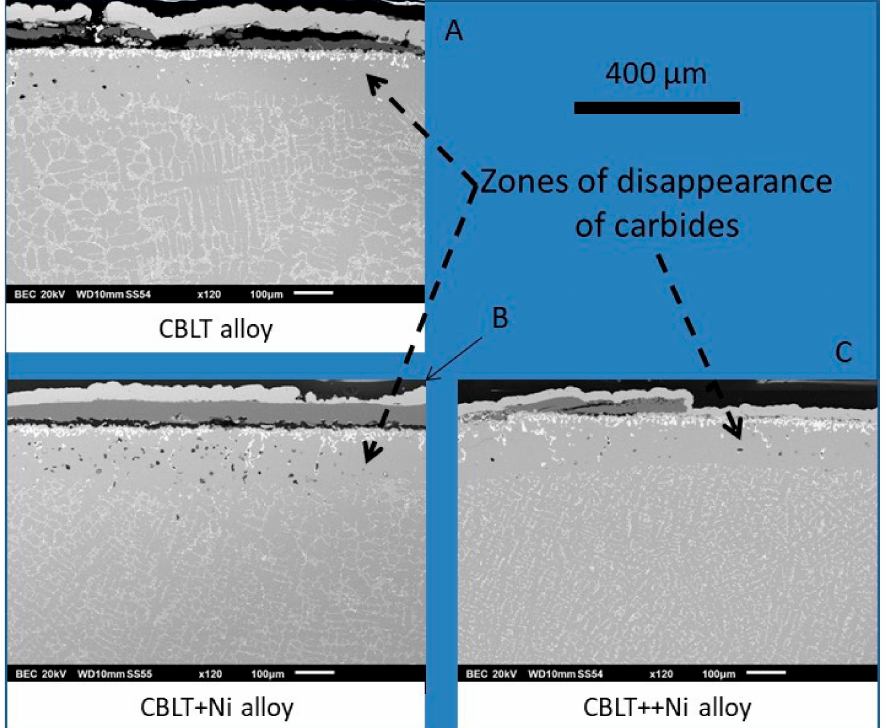
Figure 8. General view of the surfaces and subsurfaces affected by oxidation: ( A ): the CBLT alloy; ( B ): the CBLT+Ni alloy; ( C ): the CBLT++Ni alloy.